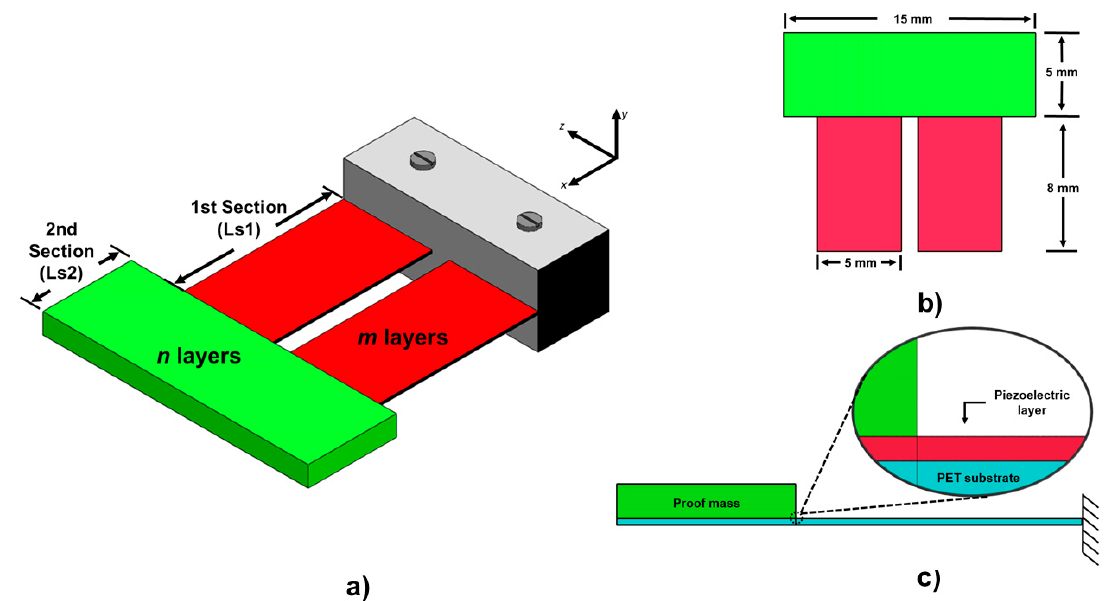
Figure 1. Design of microelectromechanical system (MEMS)-based piezoelectric energy harvesting (PEH) devices with a T-shaped structure ( a ), isometric ( b ) top and ( c ) side view of the device.